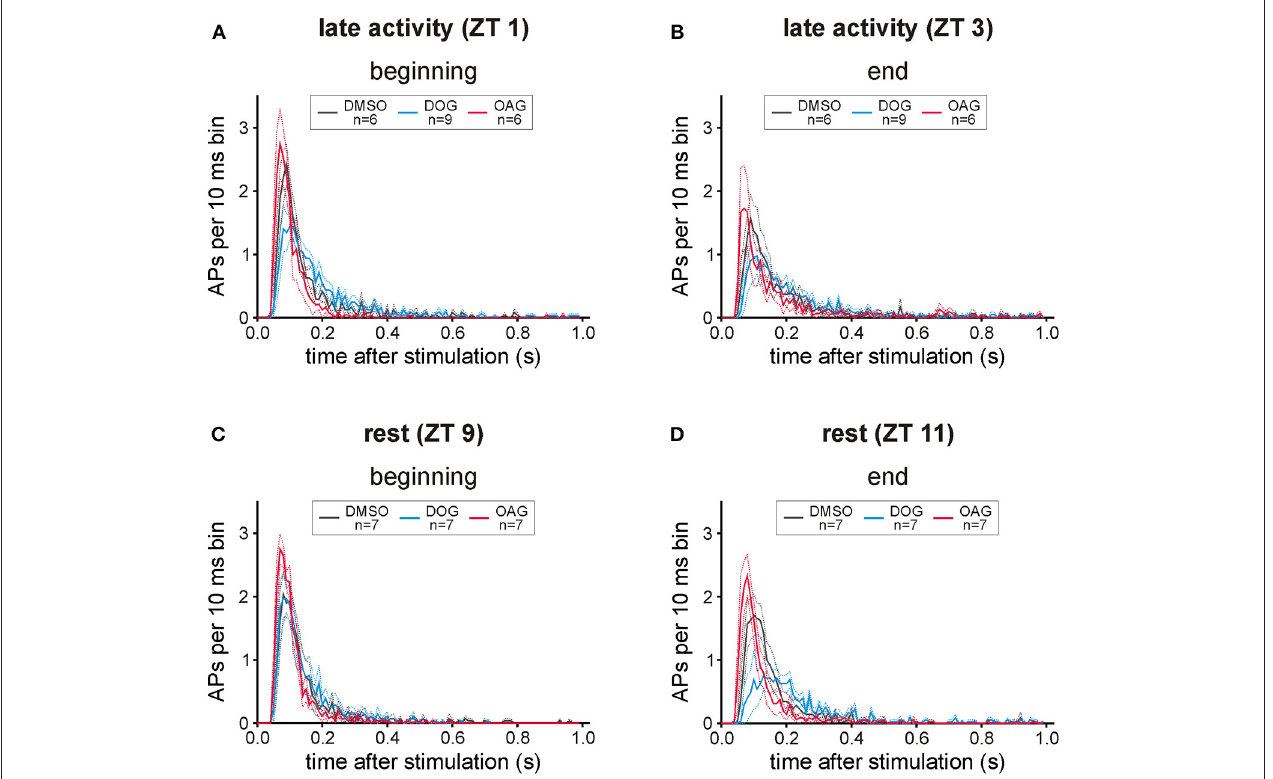
FIGURE 6 | Both diacylglycerol-analogs affected the distribution of bombykal (BAL)- dependent action potentials (APs). In post-stimulus time histograms the mean number of APs in 10ms bins was investigated for 1s after BAL stimulation in the first- and last 20min of each recording. (A) While in the first 20min of recordings in the late activity phase (ZT 1) application of 100 µ M OAG (magenta) only slightly increased and sped up the phasic-tonic response pattern, 100 µ M DOG (cyan) reduced the number of APs per bin and rendered the response more tonic. (B) This shift to slower kinetics and an adapted AP response could be seen at the end of the recordings during the late activity phase (ZT 3), also in controls and with OAG, but strongest with DOG. (C,D) Also at rest (ZT 9) the pheromone responses were stronger and faster in the presence of OAG, as compared to controls and DOG infusion. Instead, application of DOG resulted in a strong reduction of APs per bin, which resulted in a decreased more tonic pheromone response especially at the end of recordings at ZT 11 (solid lines = mean; dotted lines =